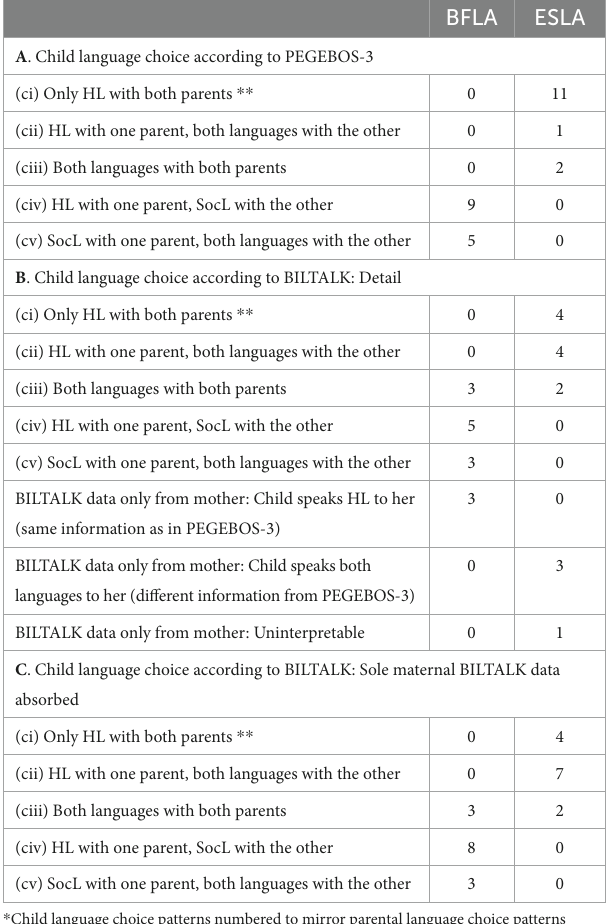
TABLE 12 Children’s language choice with parents *